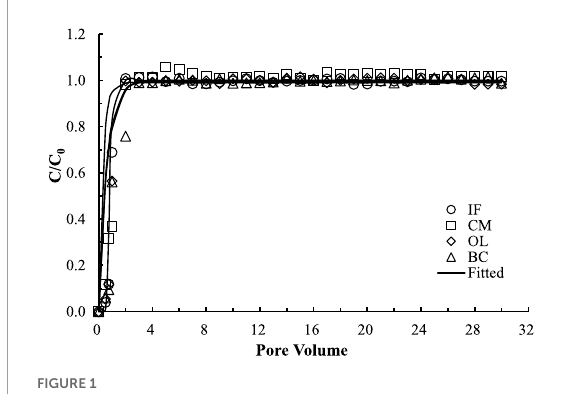
( Table 2 ). The estimated values of the first-order attachment coefficients ( K att 1 and K att 2 ) were highest in IF columns (23.15– FIGURE1 Transport of bromide ion through different porous materials. IF, iron filings; CM, calcined magnesite; OL, natural ore limestone; BC, corn stalk biochar. The lines are the modeling results with advection-dispersion equation using the Hydrus-1D software.